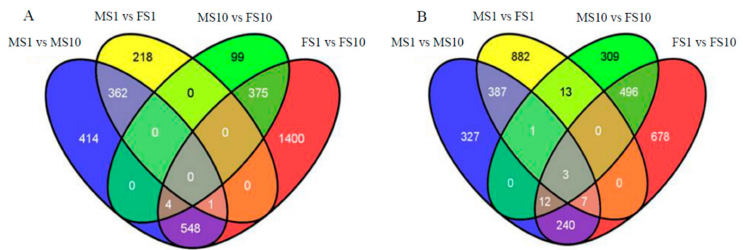
Figure 4. Number of di ff erentially expressed genes among MS1, MS10, FS1 and FS10. ( A ) Number of down-regulated expressed genes. ( B ) Number of up-regulated expressed genes. MS1 indicated samples of ‘9–6’ at LS1, MS10 indicated samples of ‘9–6’ at LS10, FS1 indicated samples of ‘2013–12’ at LS1, and FS10 indicated samples of ‘2013–12’ at LS10.